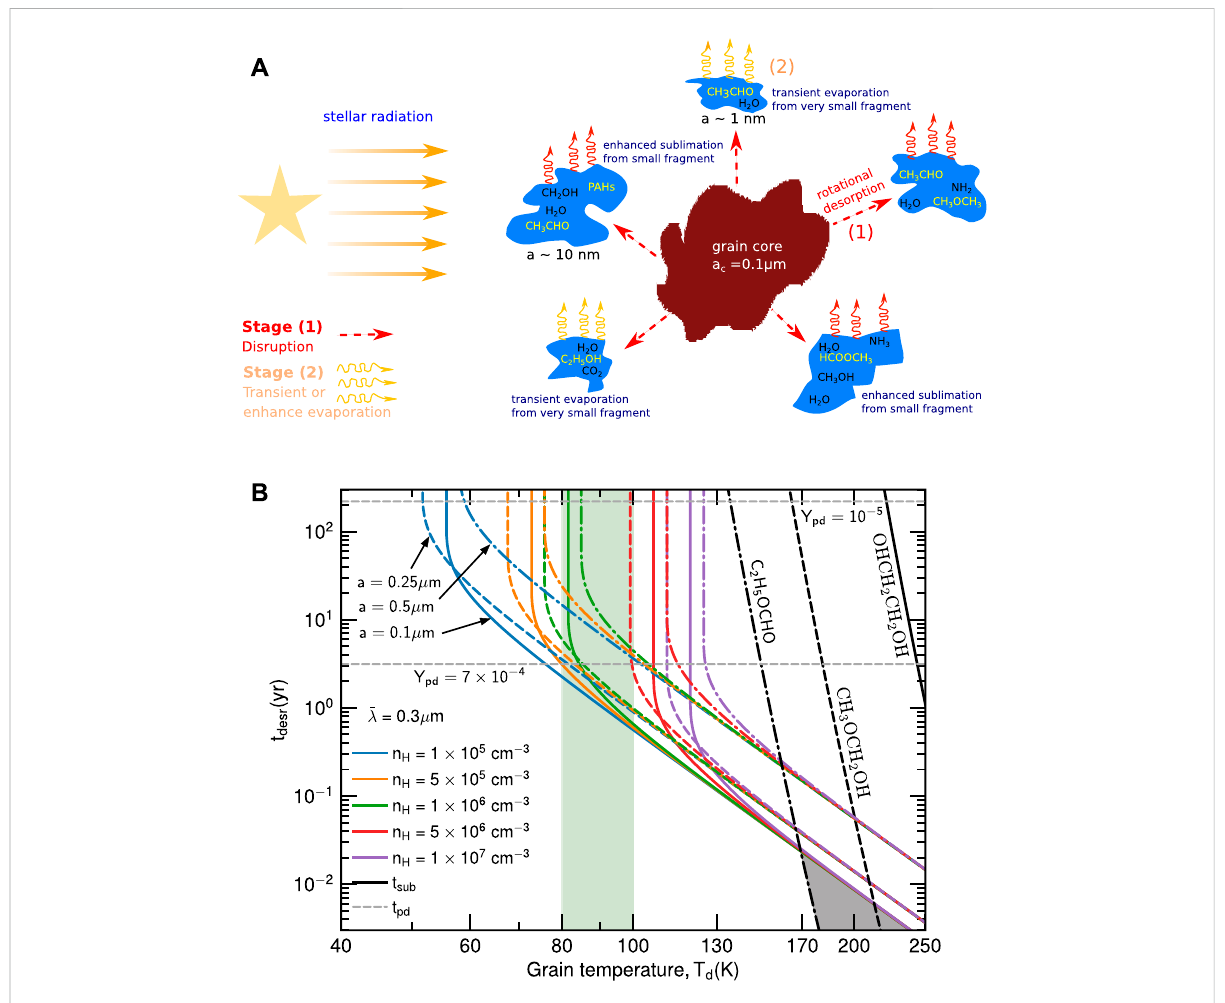
FIGURE 4 (A) Illustration of the rotational desorption process ( fi gure adopted from Hoang and Tram, 2020). There are two stages: (1) disruption of icy mantles into small fragments by the RAT-D mechanism and (2) rapid evaporation due to thermal spikes for very small fragments or increased sublimation for larger fragments. The rotational desorption is thus able to desorb complex organic molecules (COMs) formed on the icy mantle. (B) Desorption timescales of some COMs having very high binding energy in Orion BN/KL (Figure adopted from Tram et al., 2021c). The rotational desorption and sublimation are shown by the colored and black lines, whereas the UV photo-desorption is displayed by the gray dashed lines. The rotational desorption is effective for T d ≃ 80 − 100 K at which these COMs are detected (cyan area). The gray area is where the sublimation is